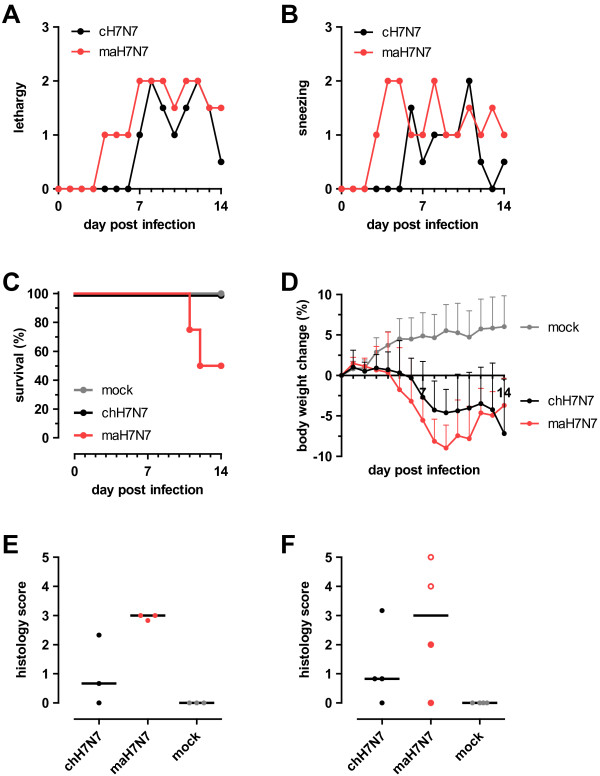
Pathogenicity of H7N7/03 viruses in ferrets. Ferrets were inoculated i.n. with 107.4 TCID50 of either maH7N7 or chH7N7 virus. As negative control, one group of ferrets was mock-infected. On day 5 p.i., 3 of the 7 animals per group were euthanized for post mortem examination. The remaining animals were monitored for clinical signs and body weight changes during 14 days p.i. A) Median scores for lethargy. B) Median scores for sneezing (if a ferret was euthanized, the last assigned score was carried forward). C) Kaplan-Meier survival curves. D) Mean body weight changes relative to baseline weights at day 0. Only 2 ferrets of the maH7N7 group remained on day 13 p.i. Error bars represent standard deviations. E, F) Semi-quantitative scoring of histopathological changes in lung tissues. Microscopic lung changes were scored on a scale of 0 to 5 as detailed in the Methods section. Each point represents the histology score of an individual animal and horizontal bars represent the median group scores. Lungs were examined E) on day 5 and F) on day 14 p.i. or when an animal needed to be euthanized before the end of the study period (one on day 11 and 12 each, shown with open circles).